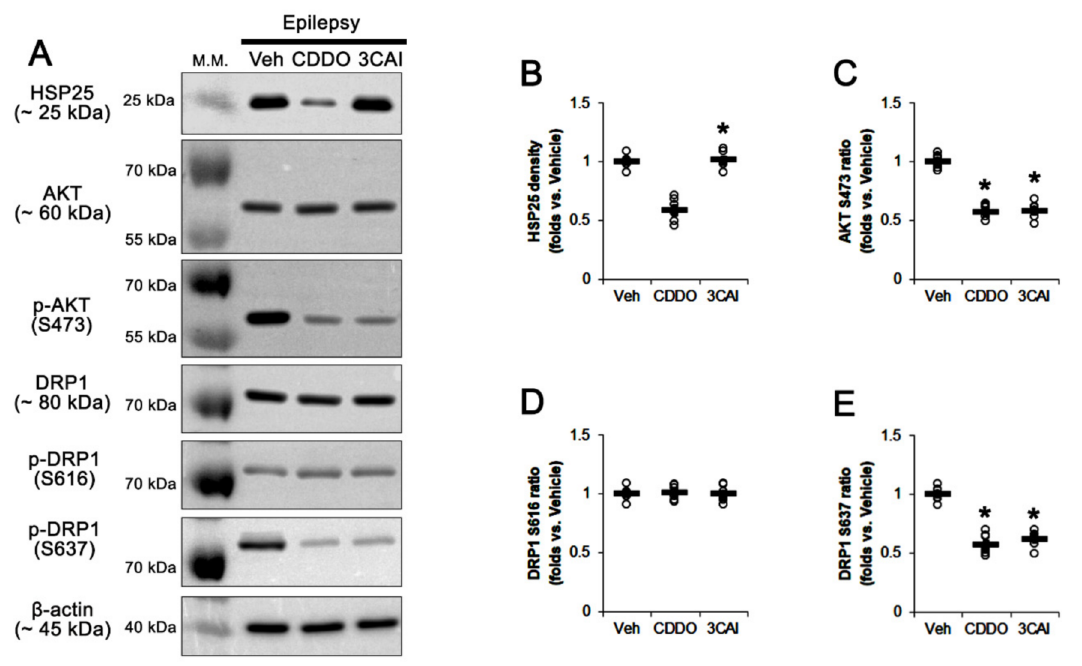
Figure 10. Effects of CDDO-Me and 3CAI on HSP25, AKT S473, DRP1 S616 and DRP1 S637 levels in the stratum radiatum of the CA1 region of epileptic rats. As compared to vehicle (Veh), CDDO-Me (CDDO) reduces HSP25, AKT S473 and DRP1 S637 levels. 3CAI decreases AKT S473 and DRP1 S637 levels. ( A ) Representative Western blot images of HSP25, AKT, AKT S473, DRP1, DRP1 S616 and Open circles indicate each value. Horizontal bars indicate the mean value. Error bars indicate SEM (* p < 0.05 vs. Vehicle, respectively; n = 7,